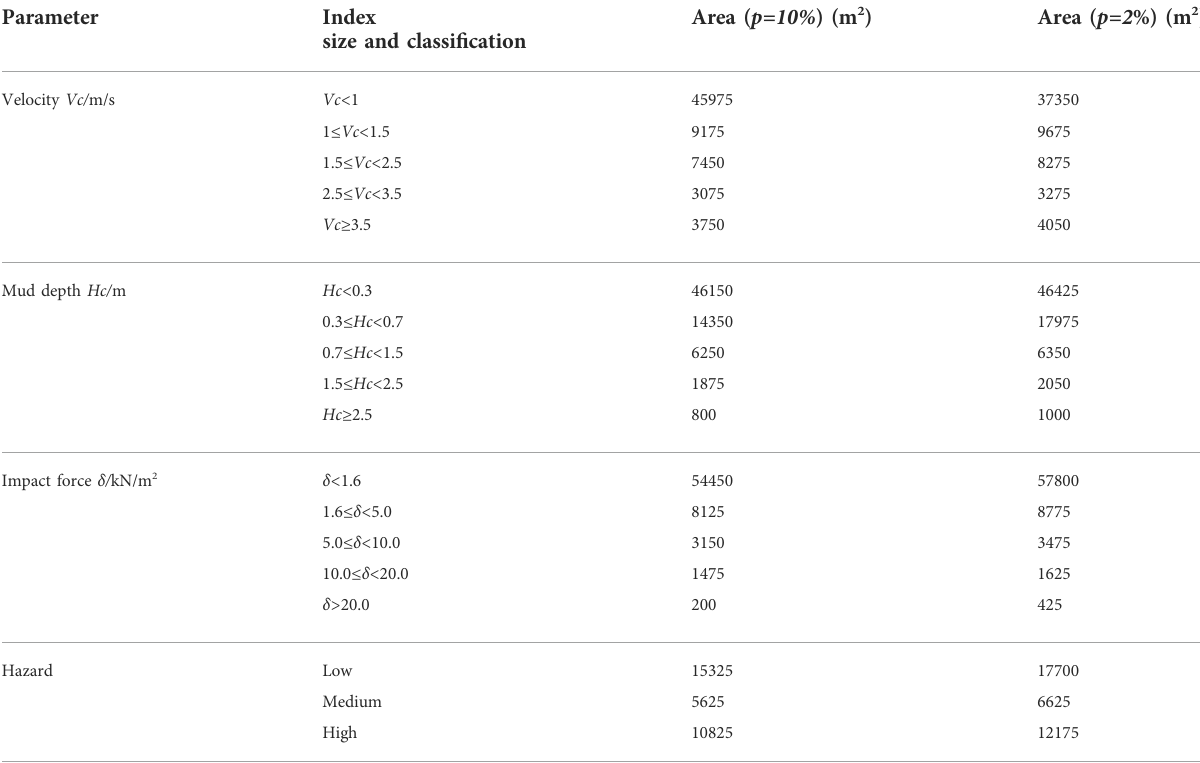
TABLE 4 Simulation and hazard classi fi cation results of debris fl ows in Zhangjiayuan gully under two precipitation